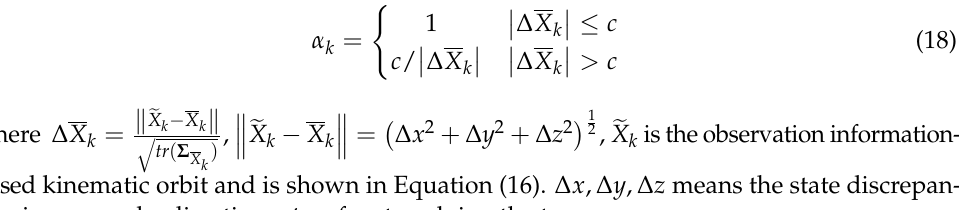
Table 1. Swarm and GRACE Constellation configurations. LEO Constellation